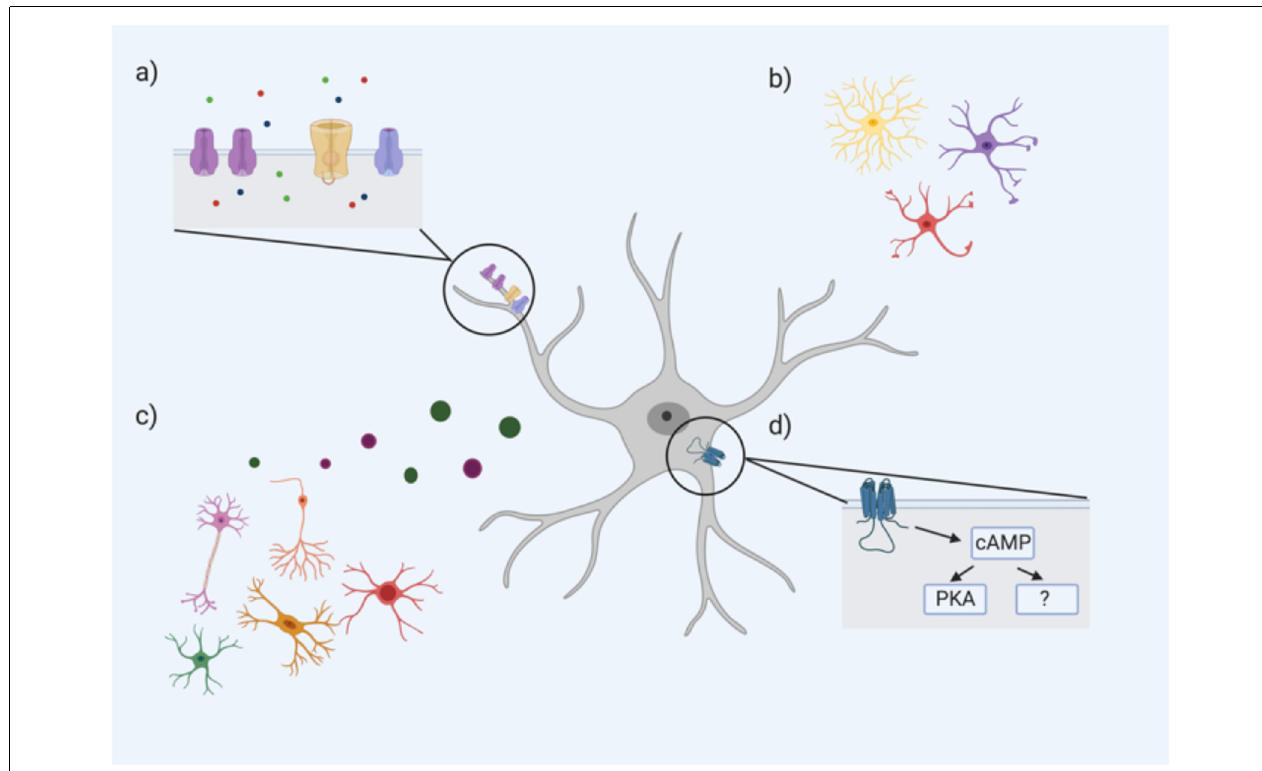
FIGURE 1 | An astrocyte’s resting membrane potential (RMP) is likely influenced by multiple extrinsic and intrinsic factors including (A) ion channel subtype expression and density, particularly Ca 2+ , Na + , and K + channels (ions represented by green, red, and blue circles, respectively); (B) astrocyte morphology; (C) neighboring cells including neurons, oligodendrocytes, microglia, and other astrocytes through the release of neurotransmitters, gliotransmitters, and other factors; (D) intracellular astrocyte signaling cascades such as the cAMP pathway. cAMP PKA-dependent and PKA-independent mechanisms have been proposed to influence astrocyte RMP (Bolton et al.,